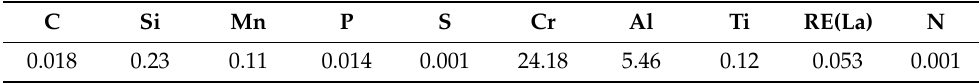
Figure 1. Schematic graph of heat treatment procedure. Table 1. The chemical composition of Fe-25Al-5Al